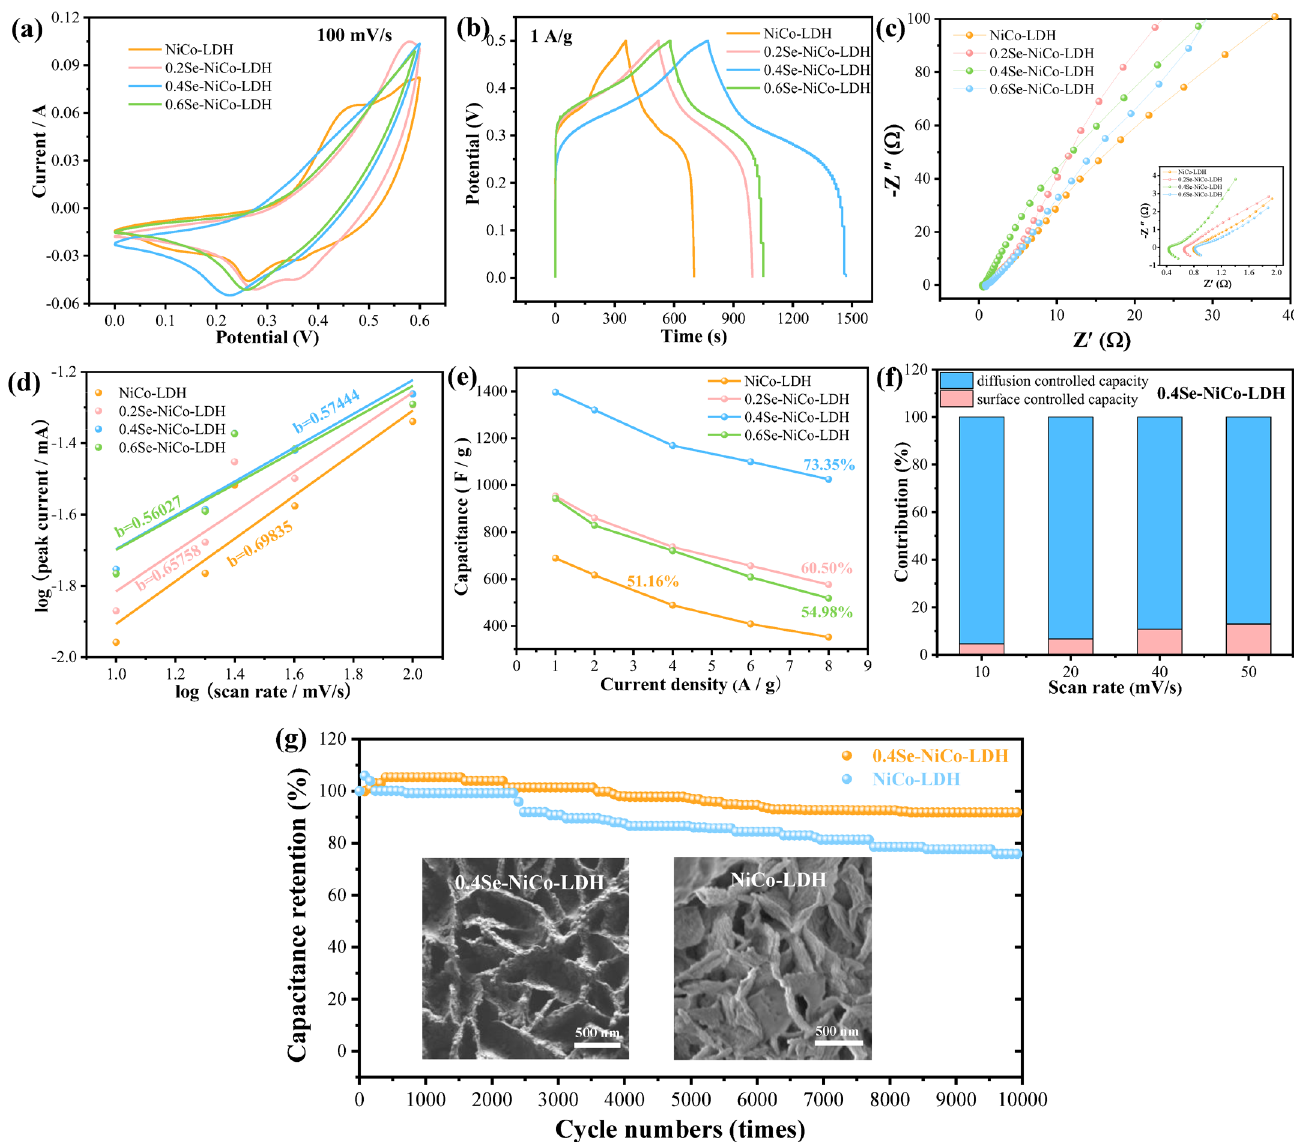
Figure 3. Electrochemical characterizations of the electrode materials. ( a ) CV curves, ( b ) GCD curves, ( c ) Nyquist plots, ( d ) b values, ( e ) specific capacitance, ( f ) contribution ratio between capacitance and the diffusion-limited result ( g ) cycling performance and SEM images after cycling.